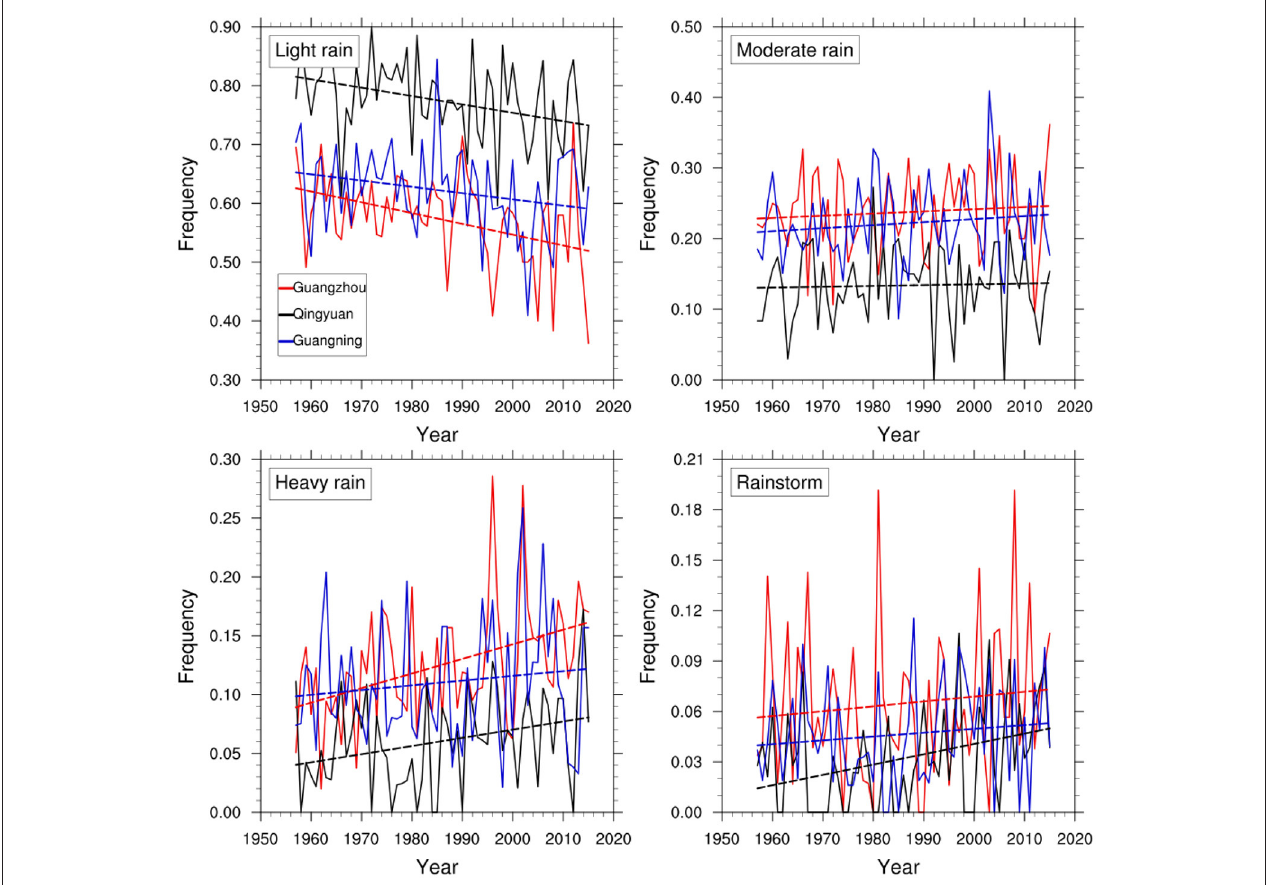
FIGURE 10 | Line (dashed lines indicate corresponding linear trends) of occurrence frequency of precipitation classes in Guangzhou (red, urban station), Qingyuan (black, suburban station) and (blue, rural station), 1957–2015.